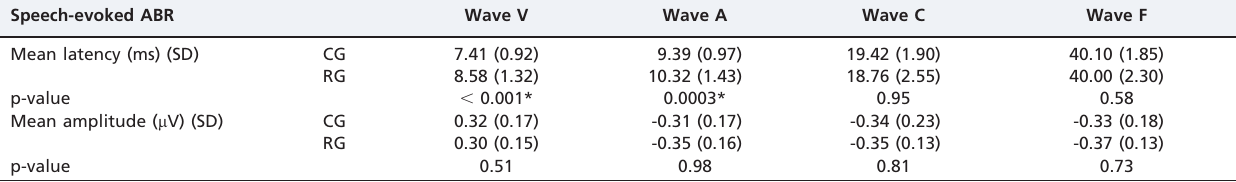
Table 2 - Control and Research Groups’ latency and amplitude means and SD of speech-evoked measures. Speech-evoked